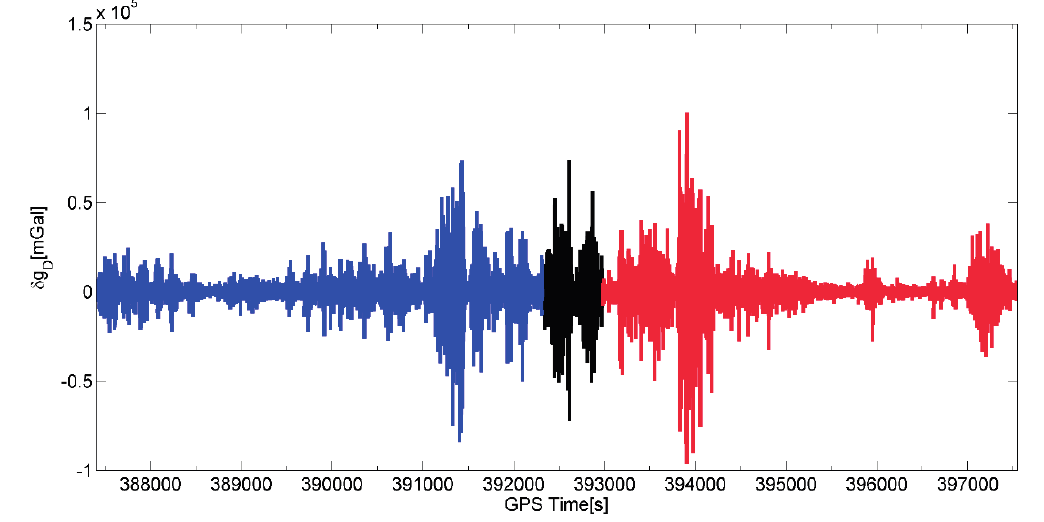
Figure 4. Raw gravity measurements (INS-GPS differences) along primary repeated flight A. The northbound flight is shown in blue while the southbound one is marked in red. The black curve between time 392,000 s and 393,000 s represents a 360° turn of the